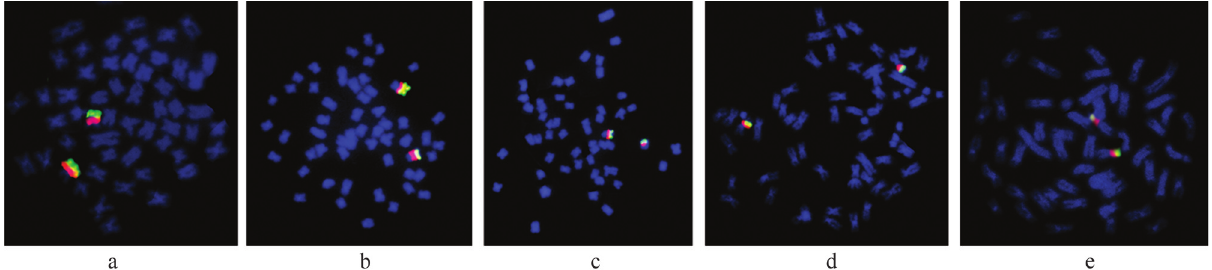
Figure 3 - Fluorescence In situ Hybridization (FISH) with 5S (green) and 18S (red) rDNA probes in: (a) P. argenteus ; (b) P. brevis ; (c) P. costatus ; (d) P. lineatus with a supernumerary chromosome, and (e) P. nigricans with a supernumerary chromosome.